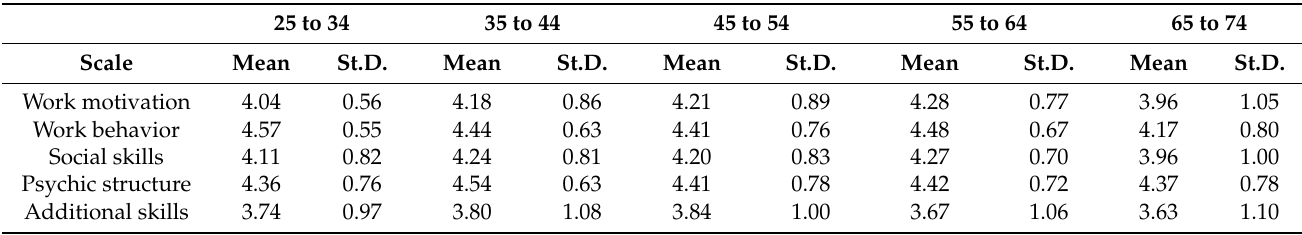
Table 7. Means and standard deviations (St.D.) of the overall answers of the different scales of the questionnaire when the sample is differentiated by age range.